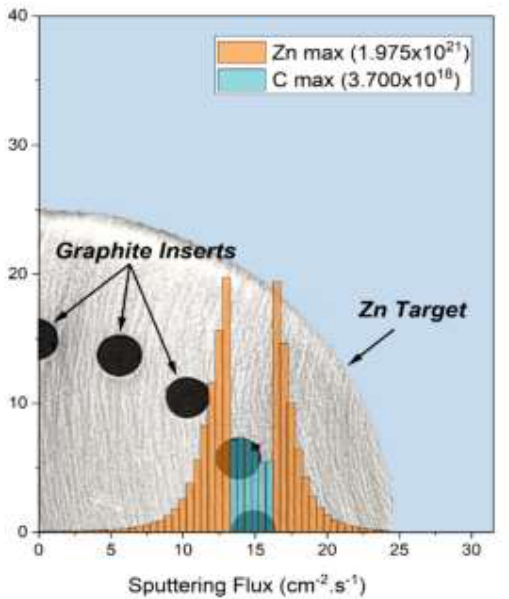
Figure 6: Simulation of the sputtered flux distribution for the zinc and carbon. The inset represents the photo for the mosaic target showing the position of the graphite inserts. Both y- and x- axes are in